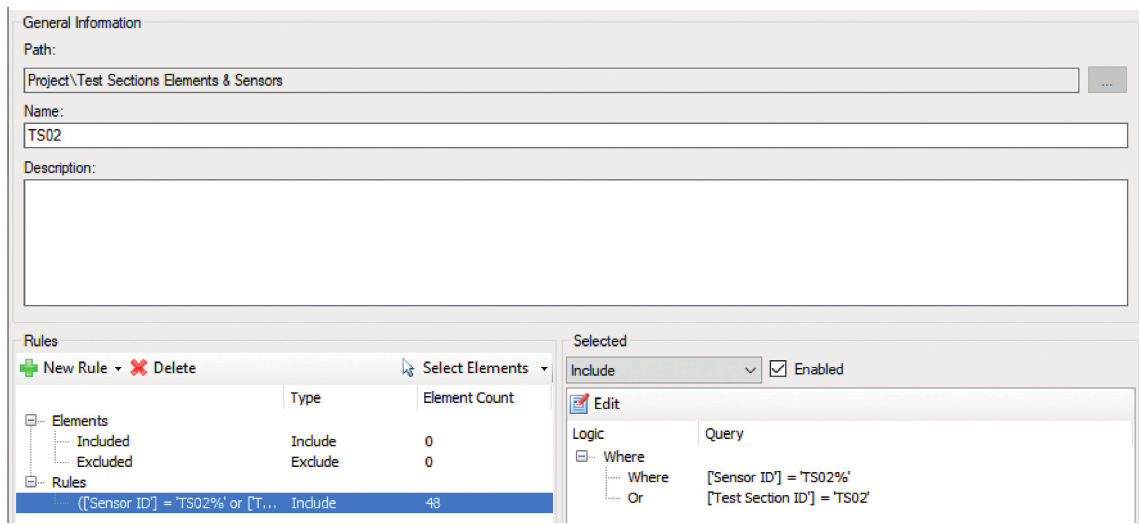
Figure 8: Smart selection